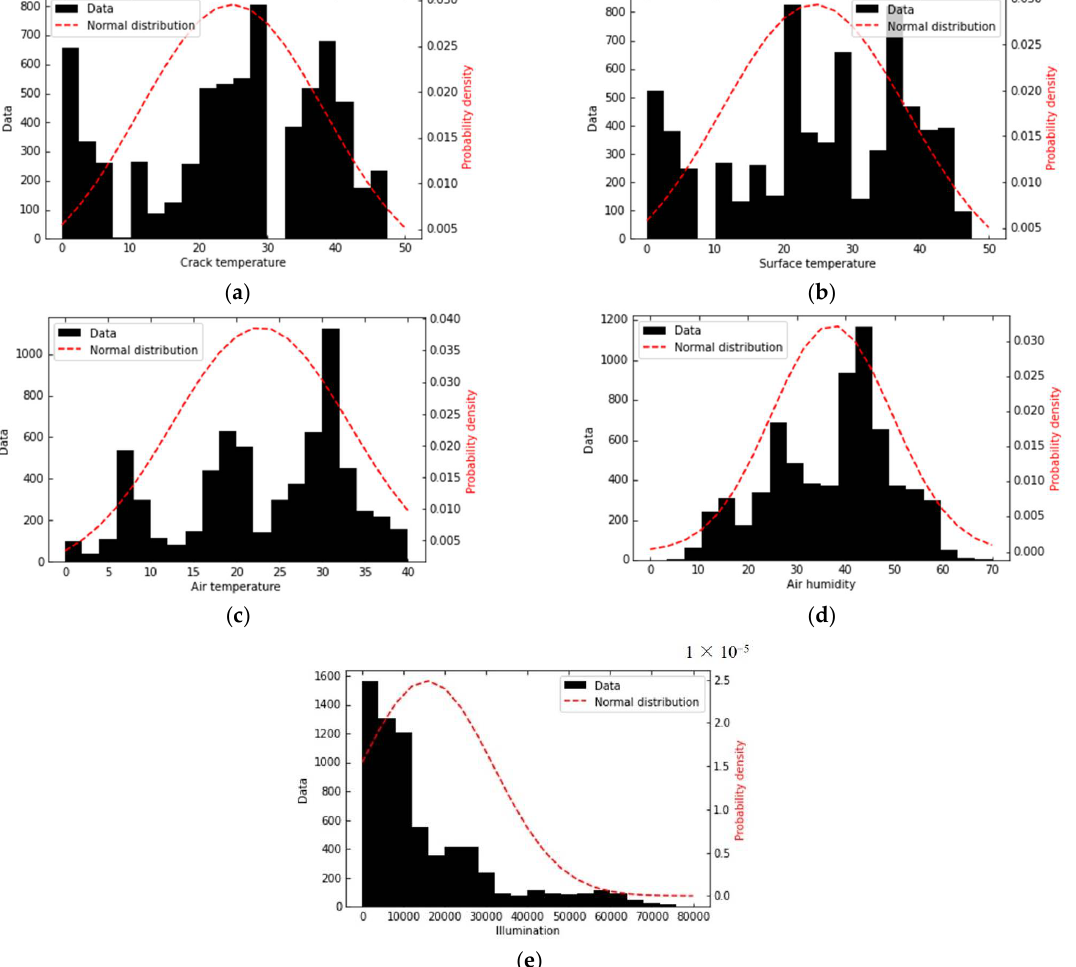
Figure 6. Normal probability distribution: ( a ) crack temperature; ( b ) surface temperature; ( c ) air temperature; ( d ) air humidity; ( e ) illuminance.